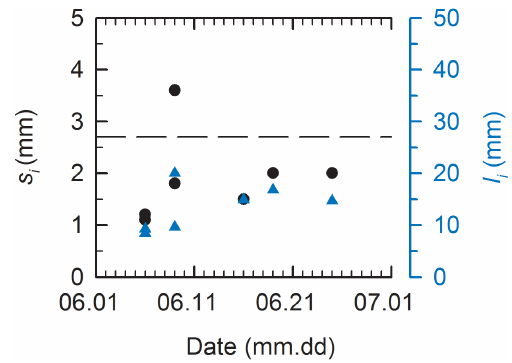
Figure 3. Time series surface rms height s i and correlation length l i of level first-year sea ice during melt onset and ponding periods. Melt ponds formed on 13 June. The dashed line denotes the upper limit of the Bragg model validity range at C-band frequency.